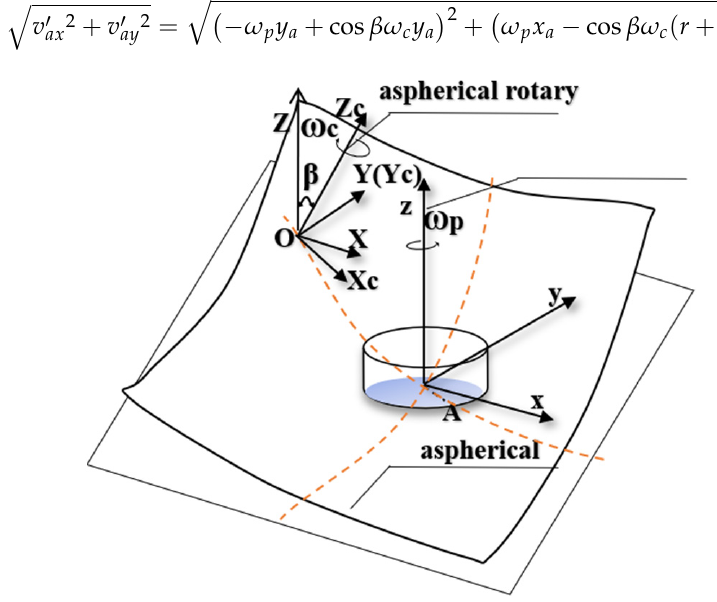
Figure 3. Schematic polishing of small polishing disc tool.